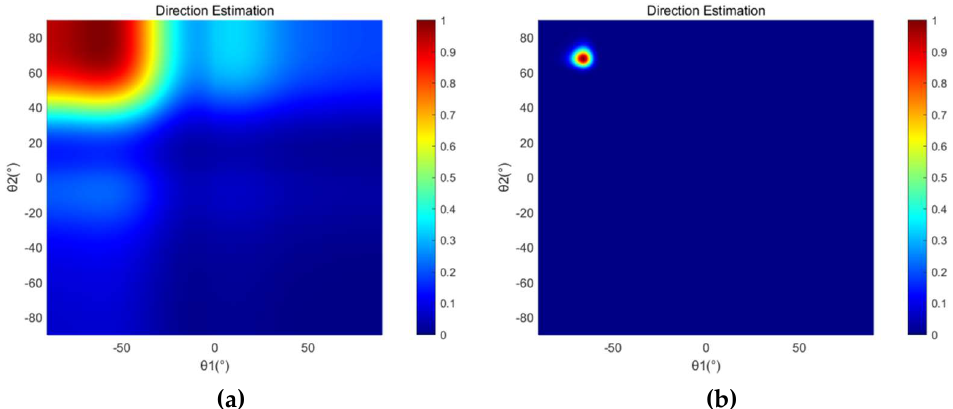
Figure 8. The direction estimation experimental results of ( a ) SRP-PHAT and ( b ) SRP-MCCC when the sound source coordinate is (10, 5).